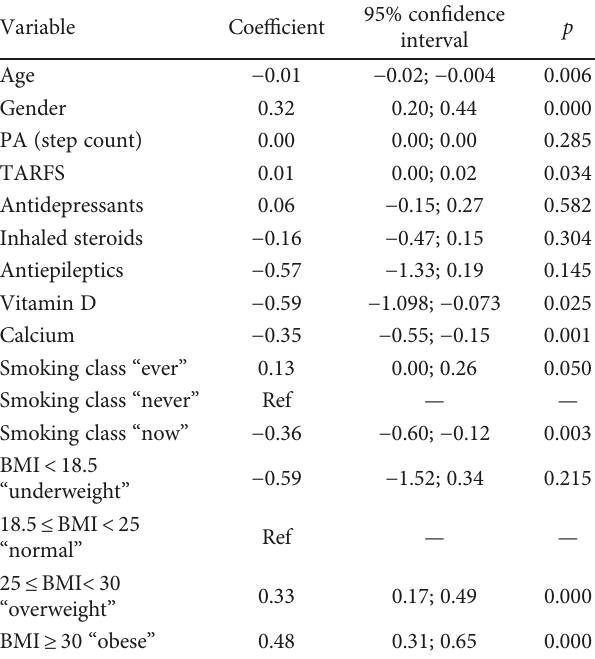
Table 5: E ff ect of covariates on QUS